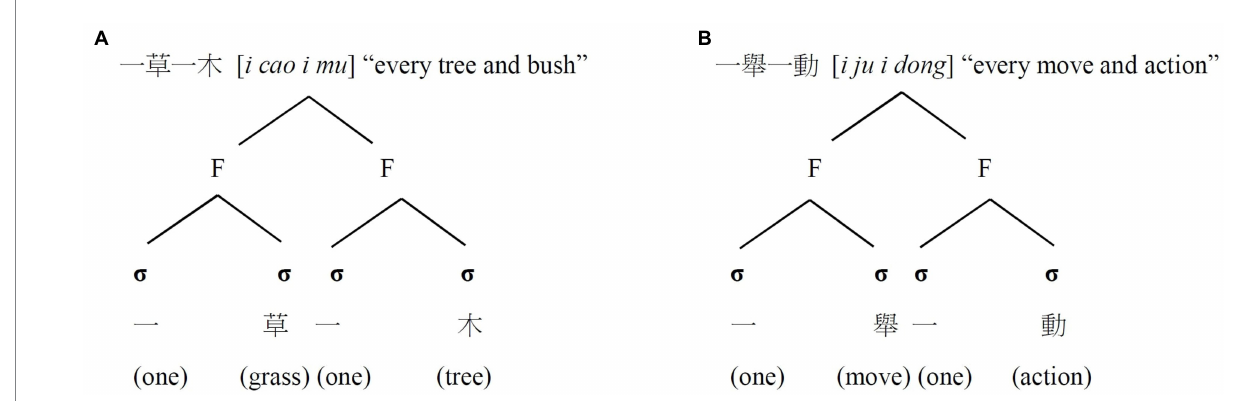
FIGURE 1 Illustration of the internal morphology of two QIEs with the same syntactic